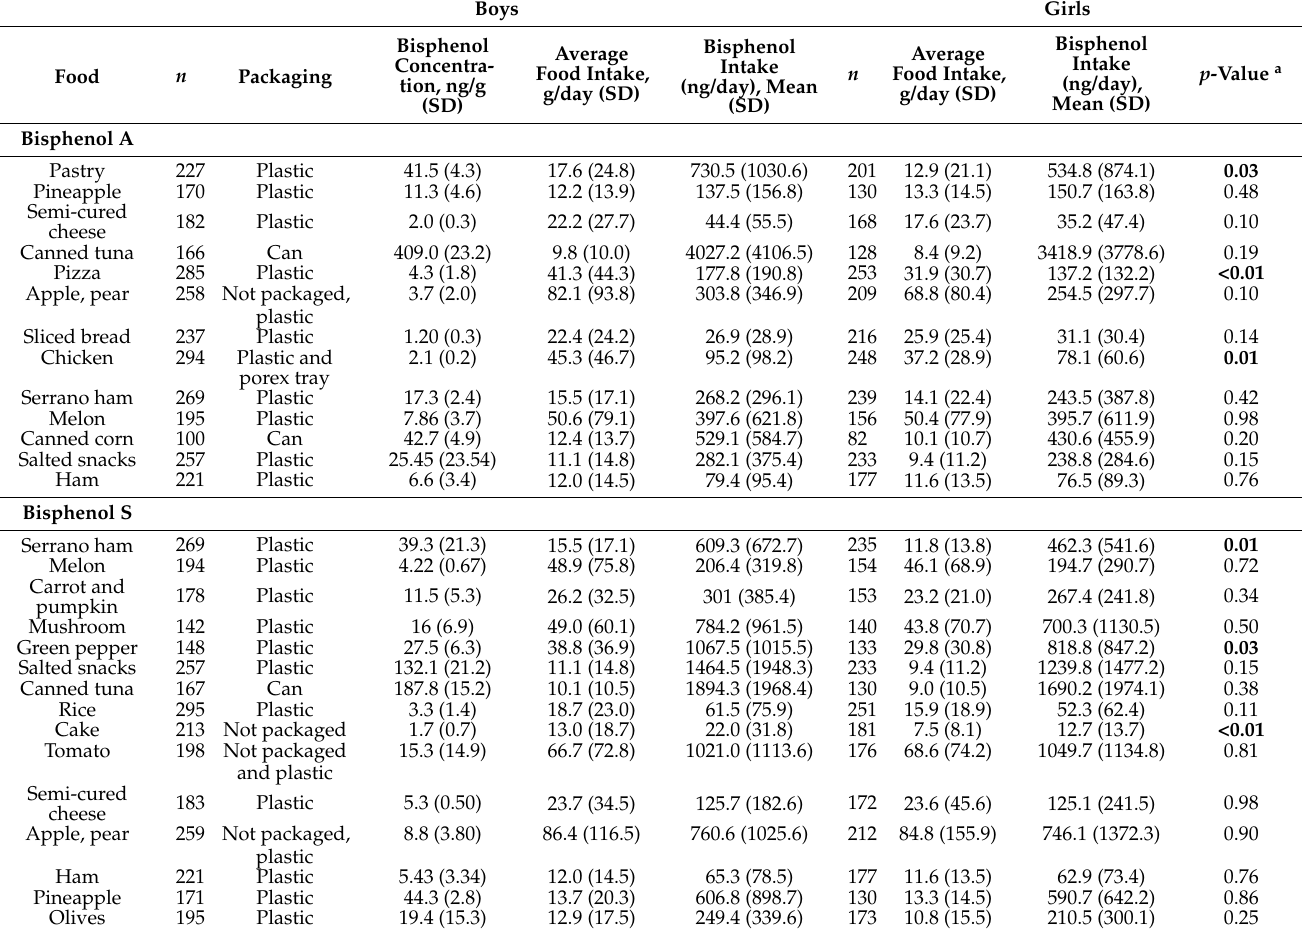
Table 2. Dietary intake of bisphenols (ng/day) according to